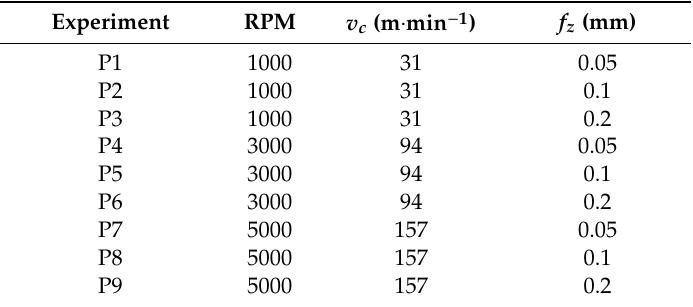
Table 4. Three-level division of trochoidal milling experiments.